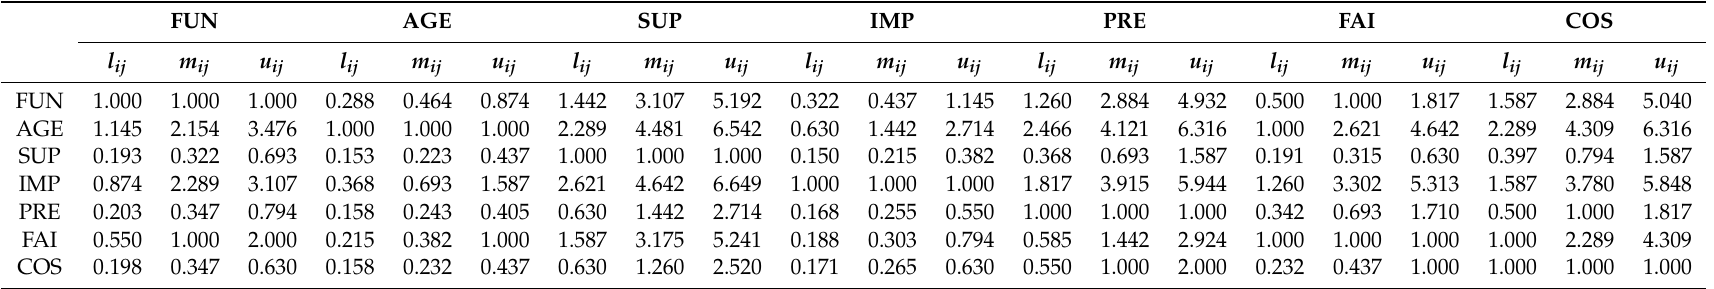
Table 3. Matrix of combined judgements using geometric means for the criteria. FUN: function of the equipment; AGE: age of device; SUP: availability of